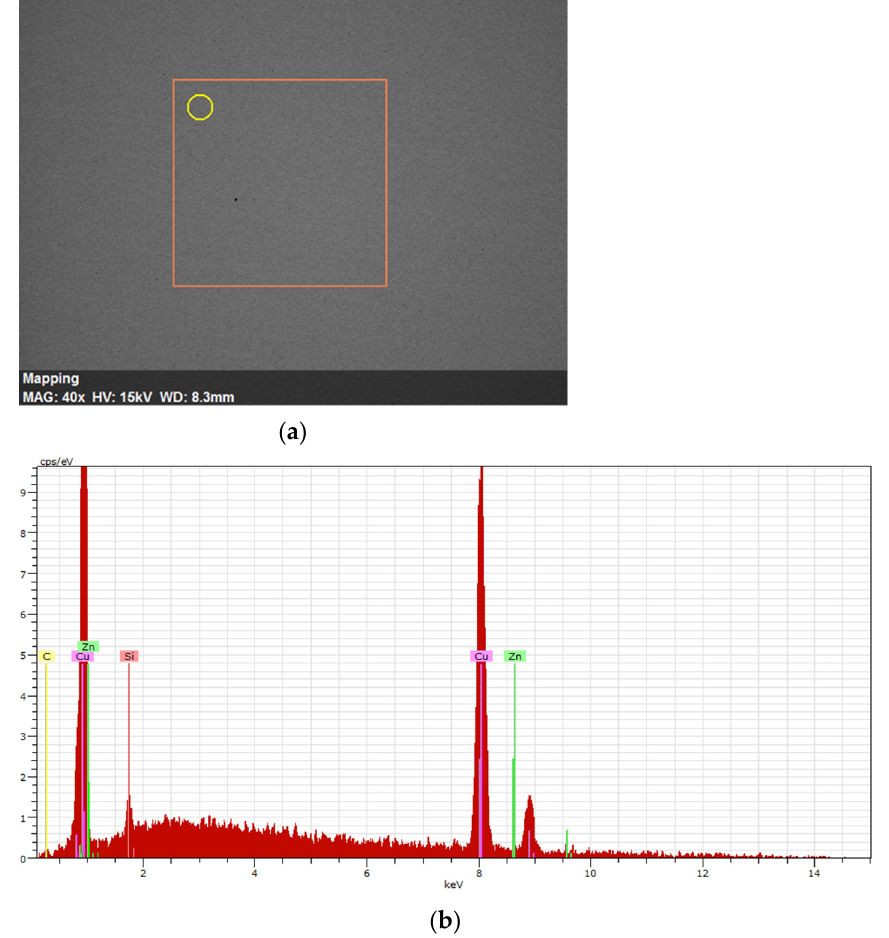
Figure 3. ( a ) SEM micrographs and ( b ) EDS analysis of the AR Cu billets (the orange frame shows the elemental mapping area, and the yellow circle shows the area of the EDS analysis).